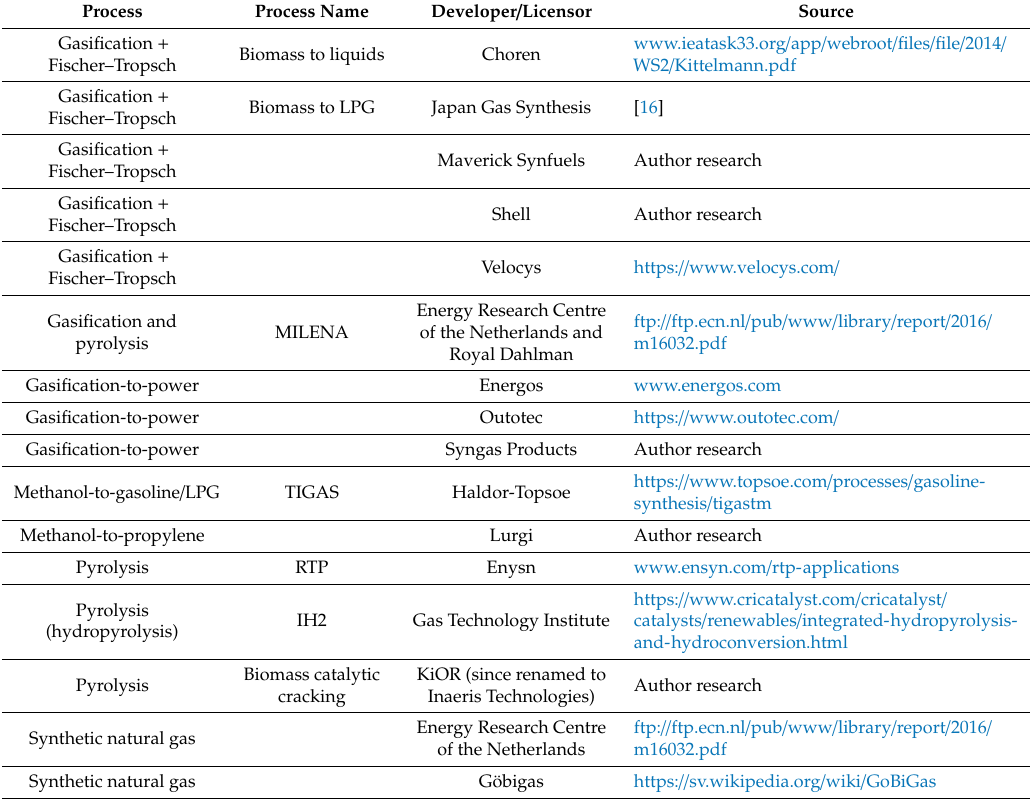
Table 7. Developers / licensors of relevant gaseous conversion and synthesis